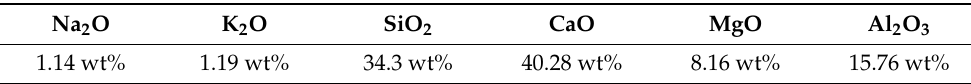
Table 3. Composition of the alkali-containing slag analyzed by ICP. Na 2 O K 2 O SiO 2 CaO MgO Al 2 O